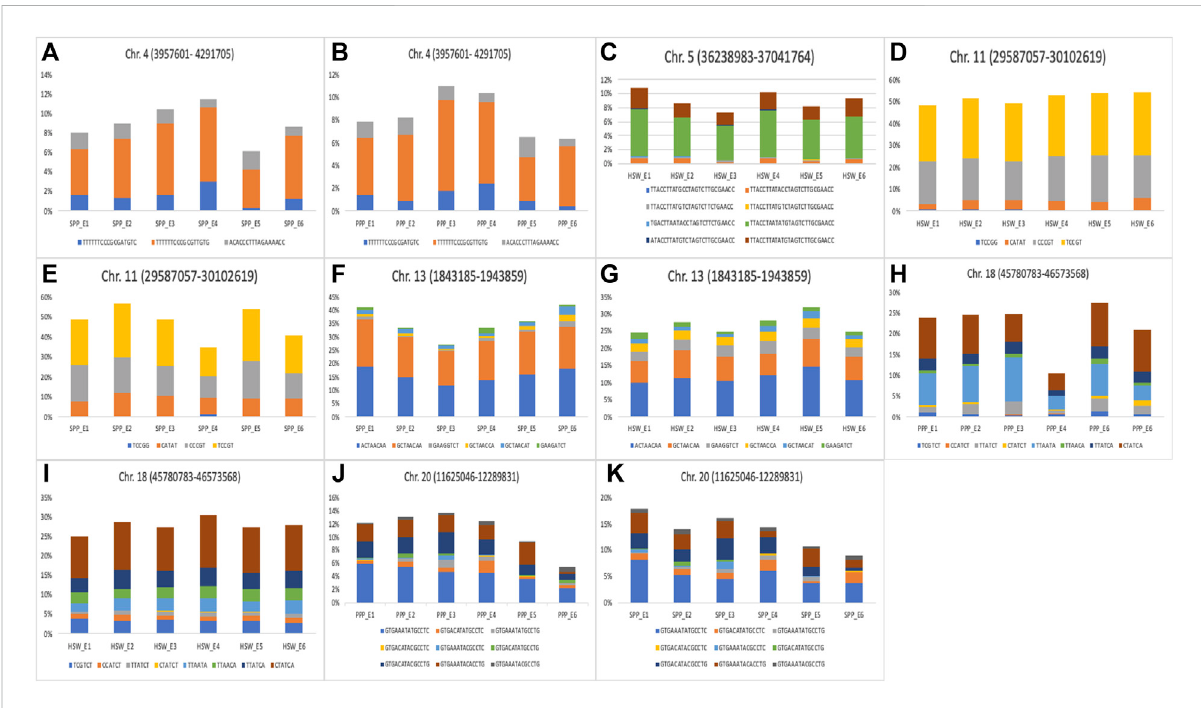
FIGURE 5 Haplotypeanalysis for yield and yield-related traits insoybean. (A – K) The barplot represents haplotype alleles identi fi edfor haplotype blockon (A) Chr.04 (3,957,601 – 4291,705 bp) (B) Chr.04 (3,957,601 – 4291,705 bp) (C) Chr.05 (36,238,983 – 3,7,041,764 bp) (D) Chr.11 (29,587,057 – 30102,619 bp) (E) Chr.11 (29,587,057 – 30102,619 bp) (F) Chr.13 (1,843,185 – 1943,859 bp) (G) Chr.13 (1,843,185 – 1943,859 bp) (H) Chr.18 (45,780,783 – 46,573,568 bp) (I) Chr.18 (45,780,783 – 46,573,568 bp) (J) Chr.20 (11,625,046 – 12,289,831 bp), and (K) Chr.20 (11,625,046 – 12,289,831 bp), and their contribution to the regulation of yield and yield-related traits. Six haplotype blocks were identi fi ed by considering six stable signi fi cant SNPs (AX-93807,406, AX-93793,210, AX-94199992, AX-93922099, AX-93703,924 & AX-94176727) as reference